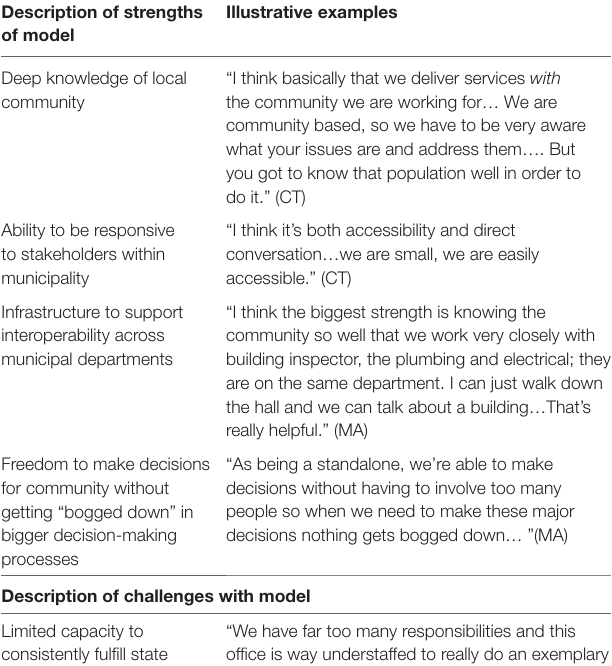
TaBle 3 | Perceived strengths and challenges of comprehensive shared service models.